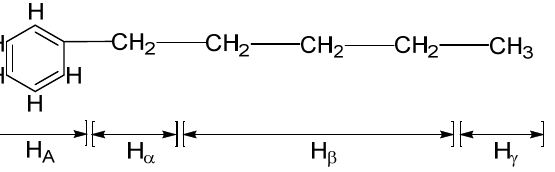
Figure 3. The schematic diagram of the attribution of H A , H α , H β , and H γ . Table 2. Types of protons in the 1 H-NMR spectrum.